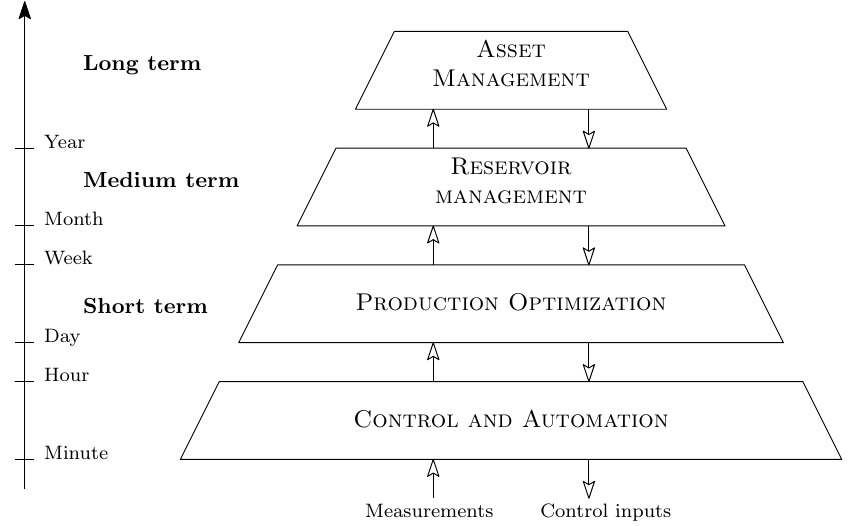
Figure 1. Typical multilevel control hierarchy in oil and gas operations as described in